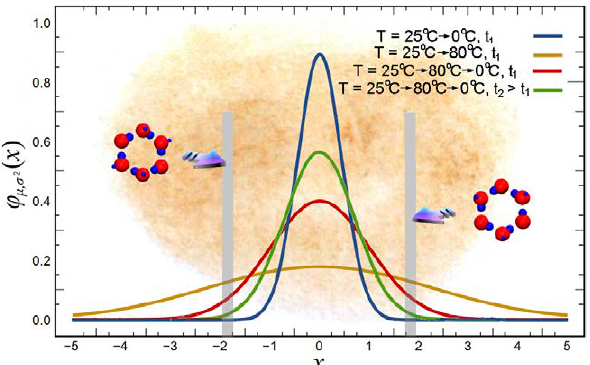
Figure 11. Probability density function of a hypothetically Gauss- ian, normally distributed variable where different x values corre- spond to specific water molecule cluster symmetry states. Gray bars denote the hypothetic cluster states common to water at high tem- peratures (circa 80 o C), but also bearing resemblance to the crystal- line symmetry present in hexagonal ice. These could be, most real- istically, hexamer states, such as those that present the basic trans- lational symmetry units in ice I h . At the same time, the delayed relaxation of high-temperature clusters and their preservation in a more dynamic, polydisperse state shortens the stochastic search for configurations that facilitate the transition to the solid state and allows the preheated water to crystallize faster when it reaches the freezing point. The representation should be noted for its simplic- ity, given the greater complexity of water cluster states, in perpetu- ally fluctuant states of constant formation and dissipation, than that depicted